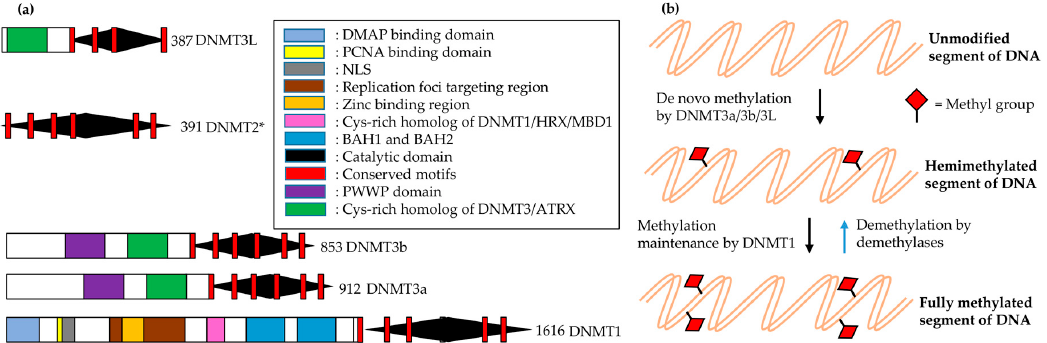
Figure 5. Members of mammalian DNA methyltransferase (DNMT) families. ( a ) Structural comparison of all mammalian DNMTs; ( b ) function of each member for DNA methylation: initial CpG